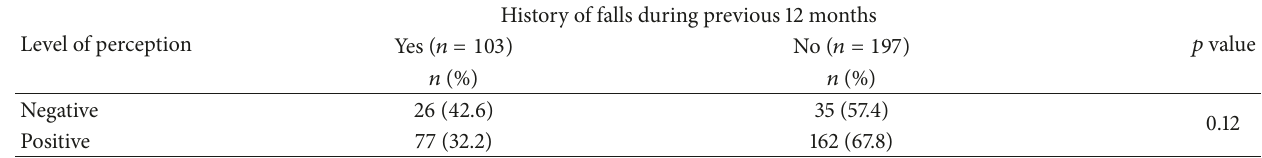
Table 7: Association of perception with the history of falls ( 𝑛 = 300